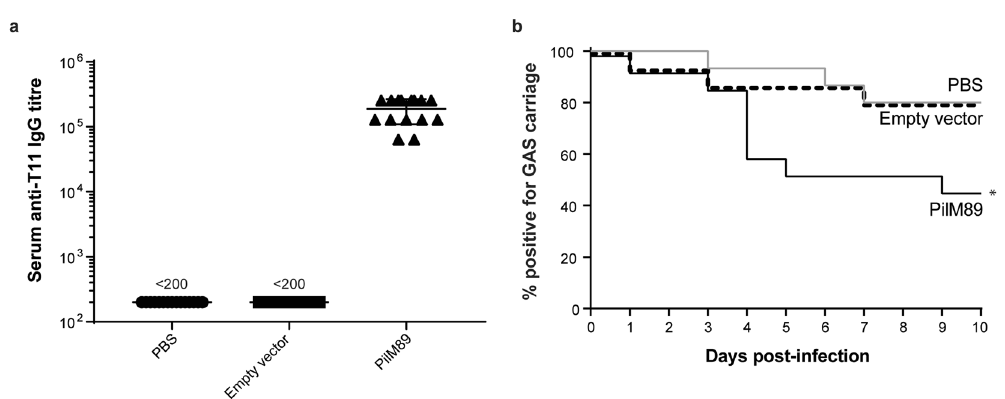
Figure 6. Intranasal immunisation of mice protects against nasopharyngeal challenge. FVB/n mice (n = 15) were immunised intranasally with PBS, L . lactis empty vector, or L . lactis PilM89. Serum was collected 10 days after the final immunisation and antibody responses measured against recombinant T11-antigen by ELISA ( a ). Mice were subsequently challenged intranasally with 10 8 CFU GAS M89T11 and monitored for nasal shedding of bacteria daily. The percentage of mice positive for at least 1 CFU of GAS is displayed ( b ). Data combines two independent experiments. * p < 0.05, Logrank test for